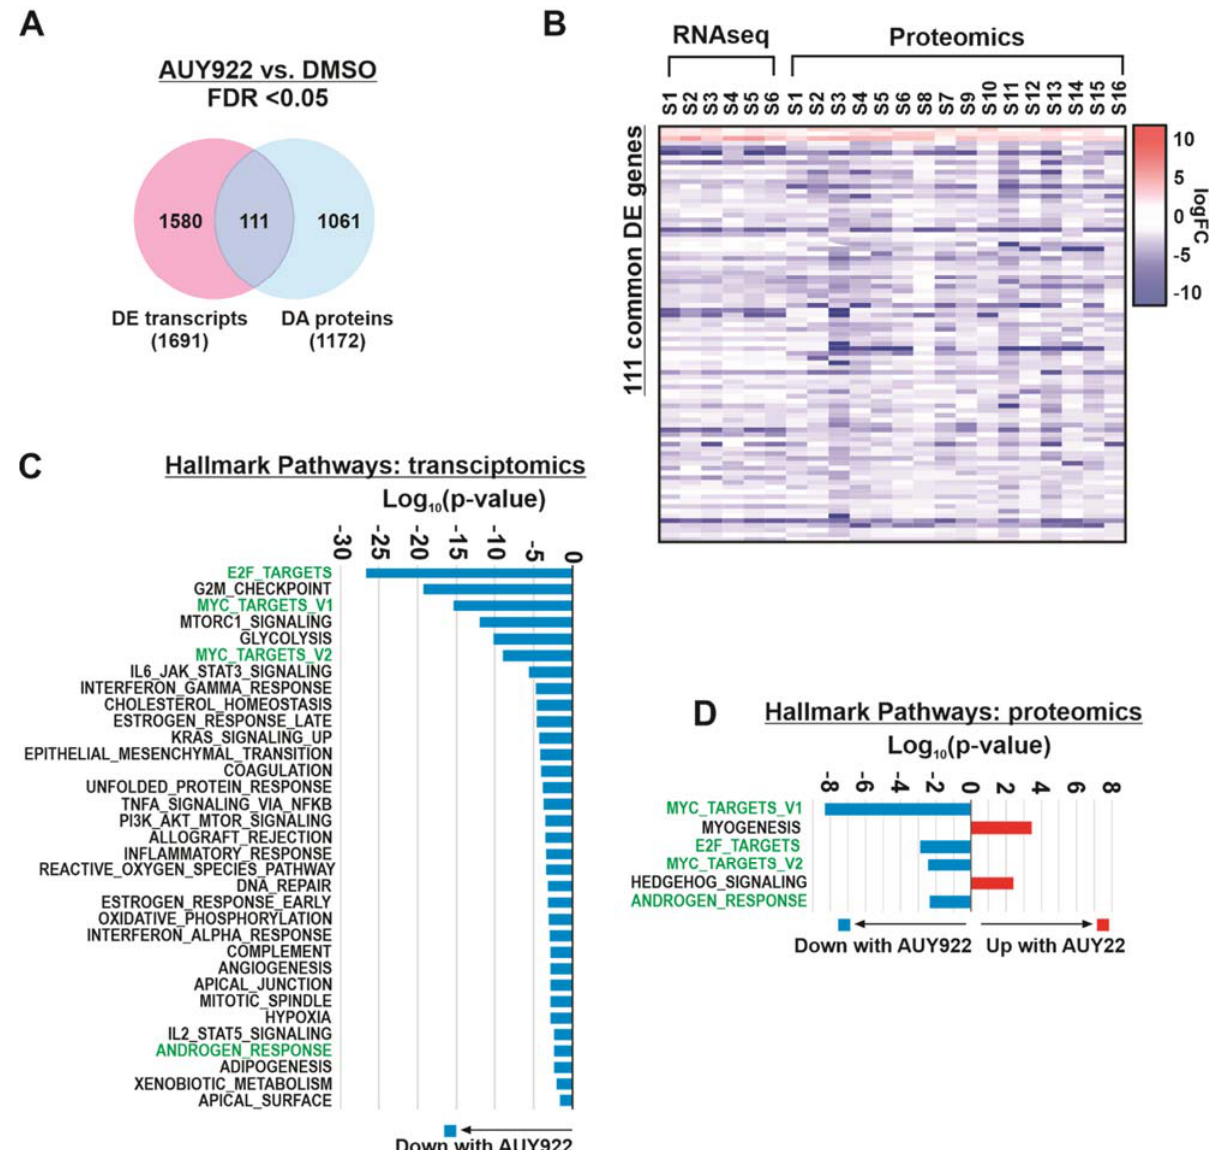
Figure 5. Omics analysis of patient-derived explants identified key biological pathways and novel targets. ( A ) Venn diagram representing the overlap between genes and proteins identified as differentially expressed (DE) or differentially abundant (DA) in AUY922 treated PDEs versus DMSO (FDR < 0.05). ( B ) Heatmap representing 111 genes/proteins that were identified both as differentially expressed in the RNAseq analysis and differentially abundant in the proteomics analysis. ( C , D ) Pathway over-representation analysis of ( C ) DE genes and ( D ) DA proteins from Venn diagram in A. Pathways highlighted in green were identified by both RNAseq and proteomics analysis.